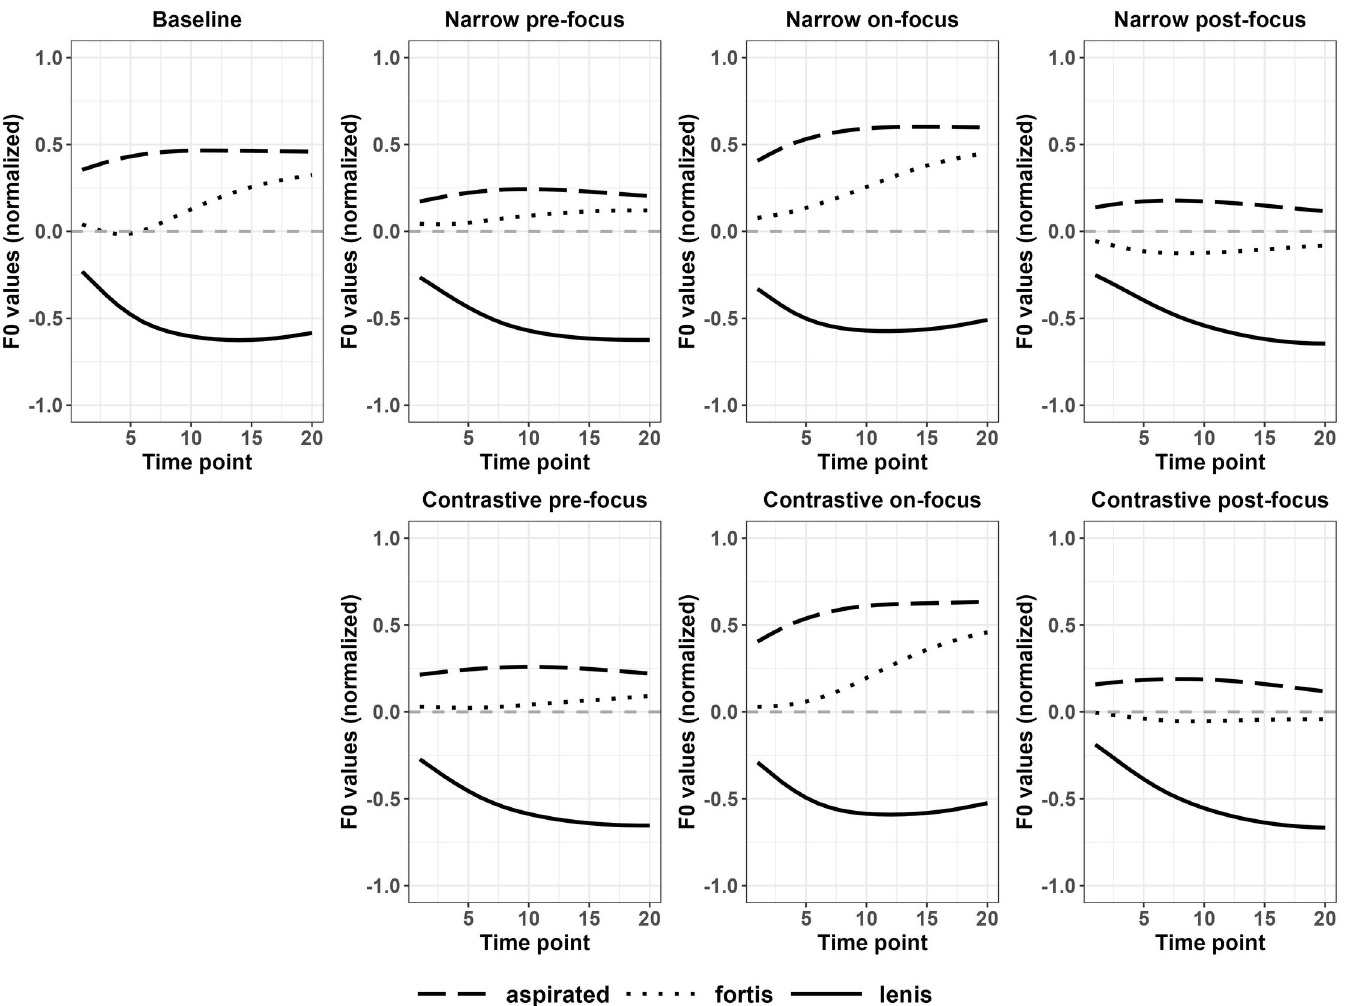
Fig 8. Normalized f0 contours of disyllabic targets under different discourse conditions (Korean).